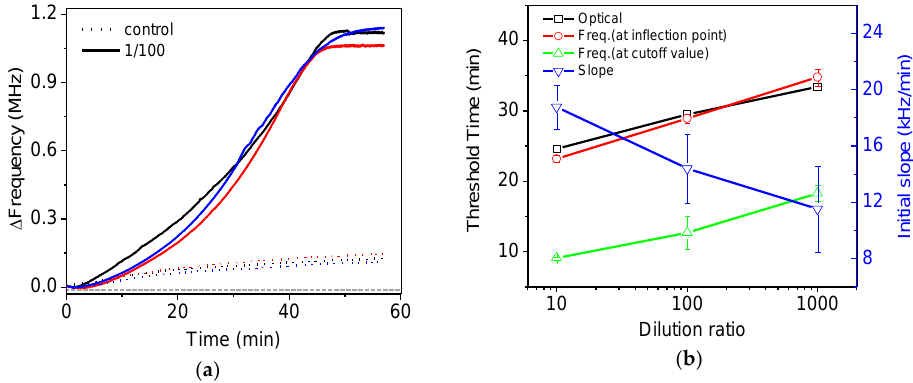
Figure 8. ( a ) Reproducible frequency variations in the 1/100 diluted and control samples during isothermal amplification; ( b ) the estimated threshold time from variations in the fluorescence intensity (black open square) and frequency by using various methods such as the frequency at the inflection point (red open square), the frequency at the cutoff value of the control experiment (green open triangle) and the initial slope at early stage (blue reverse open